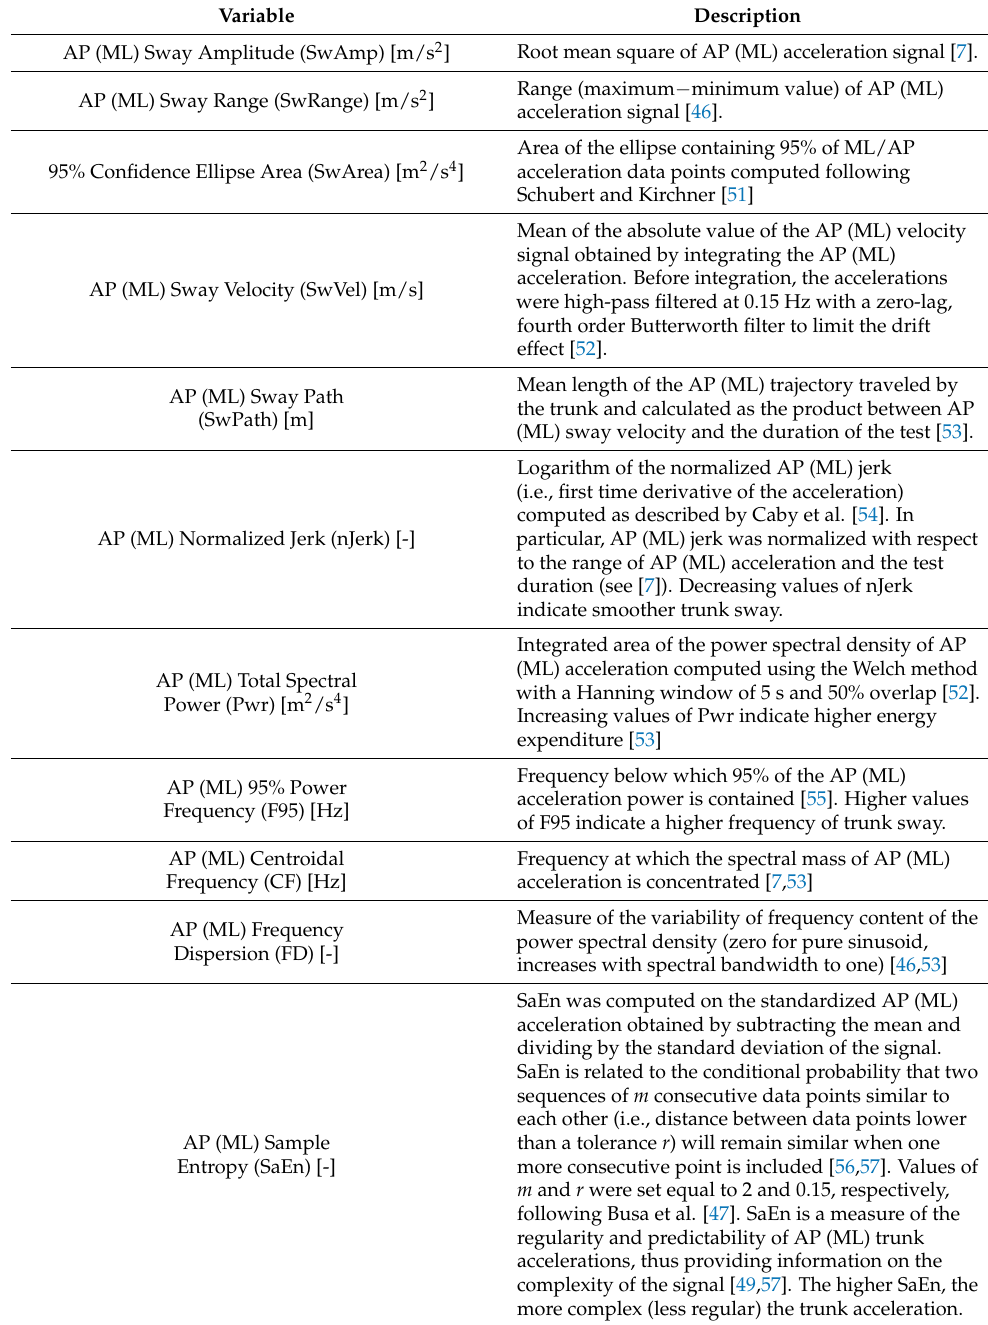
Table 1. Description of the wearable-sensor-based variables computed during the instrumented modified Romberg Test